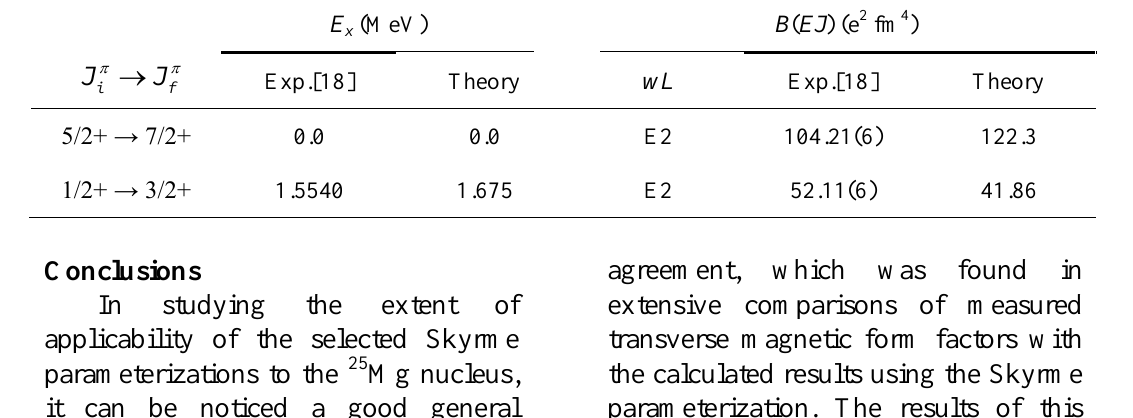
Exp. Fig. 5: Energy levels for the positive parity states of 25 Mg nucleus compared with experimental data taken from [20].